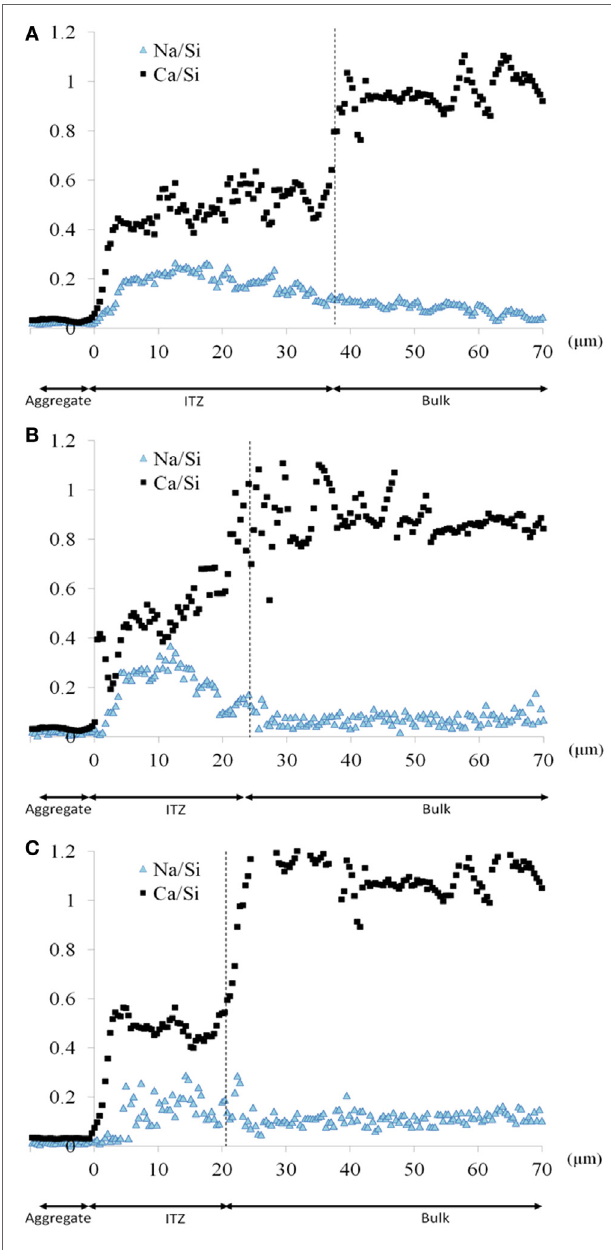
FigUre 7 | relative proportion of different phases (unreacted slag, inner product, outer product, and porosity > 1 μ m diameter) in the low-alkalinity alkali-activated slag mortar, for each sand type .